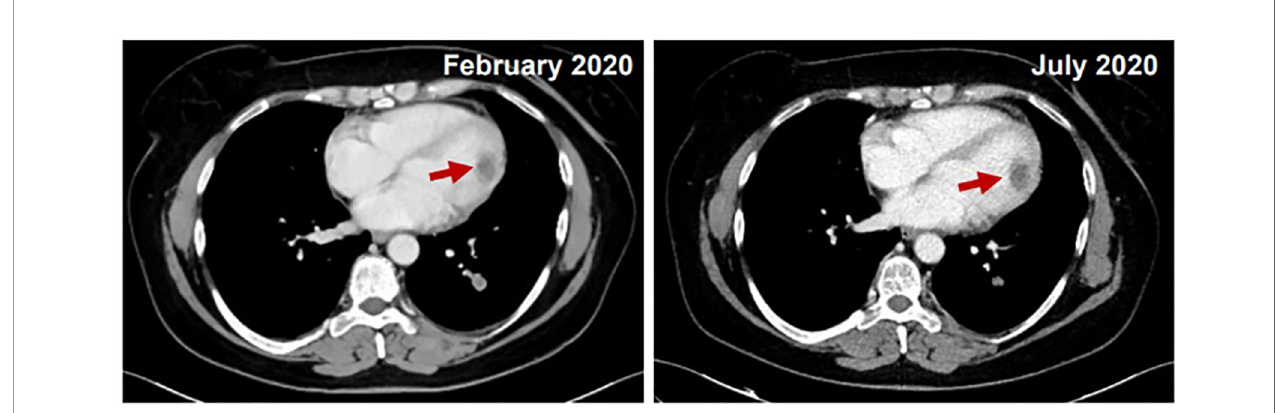
FIGURE 3 | Comparison between February 2020 (on the left) and July 2020 (on the right): CT stability of cardiac mass and pulmonary and renal partial response.